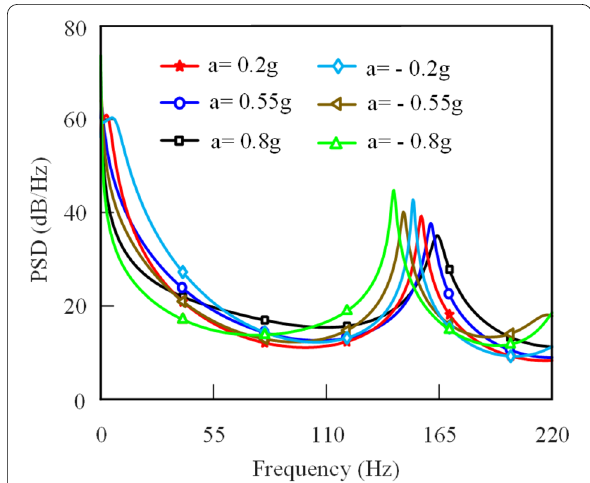
Figure 9 Frequency response of spindle system under different accelerations and